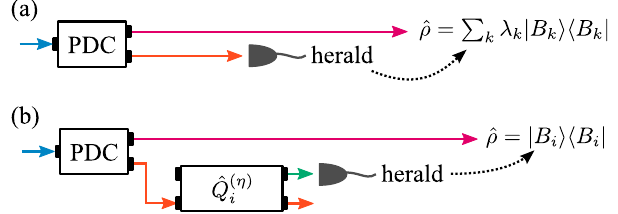
FIG. 8. (a) Non-mode-selective detection of one PDC photon generally projects its sibling into a mixed state. (b) Deploying a QPG to herald a single TM yields a pure heralded broadband photon at the cost of a lowered heralding rate.